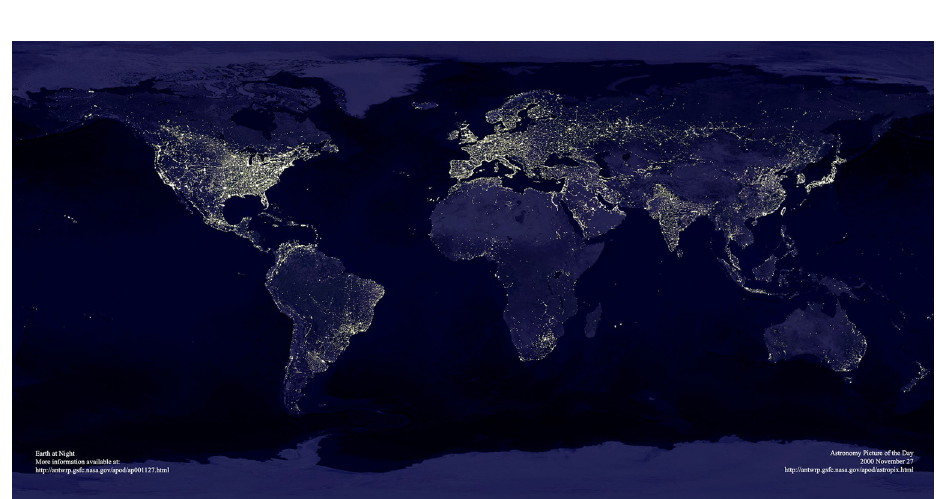
Fig. 1. – The Earth lights at night. This a composite image of hundreds of pictures made by the orbiting Defense Meteorological Satellite Program (DMSP) satellites [1].